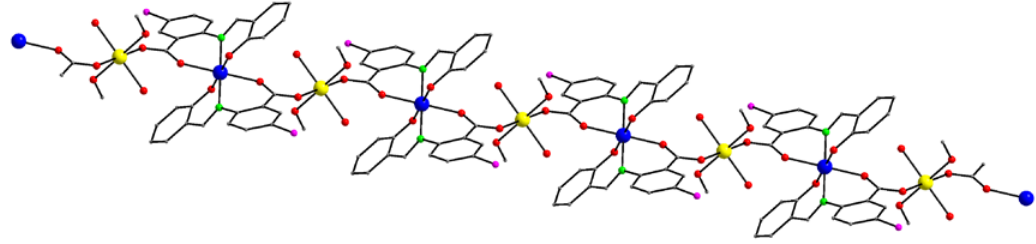
Figure 4. Representation of a section of the 1-D chain of 2 , showing the alternating {Mn III (sacb) 2 } − and {Mn II (MeOH) 2 (H 2 O) 2 } 2+ subunits. Color scheme as in Figure 3.